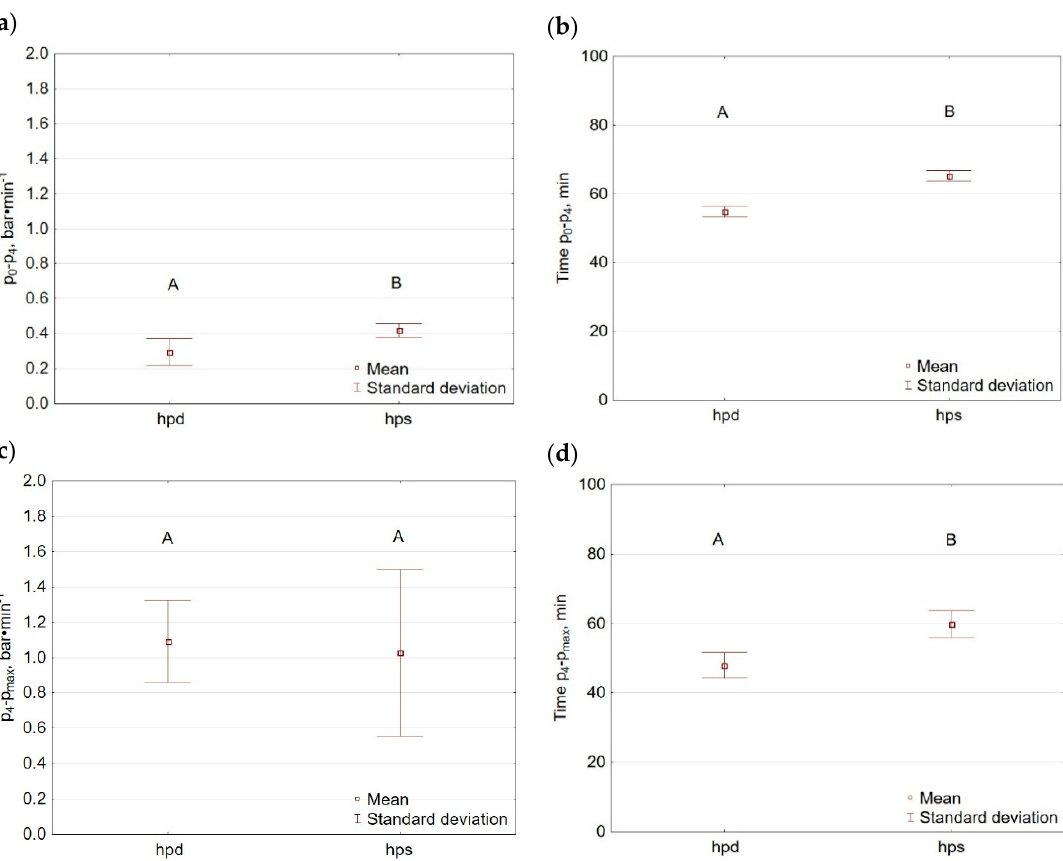
Figure 8. The pressure-increase rate of the reactor and time to a particular pressure point, ( a ) pressure rate for 0 to 4 bar, ( b ) time from pressure increase start to pressure 4 bar, ( c ) pressure rate from 4 bar to max process pressure, ( d ) time from pressure 4 bar to max pressure.